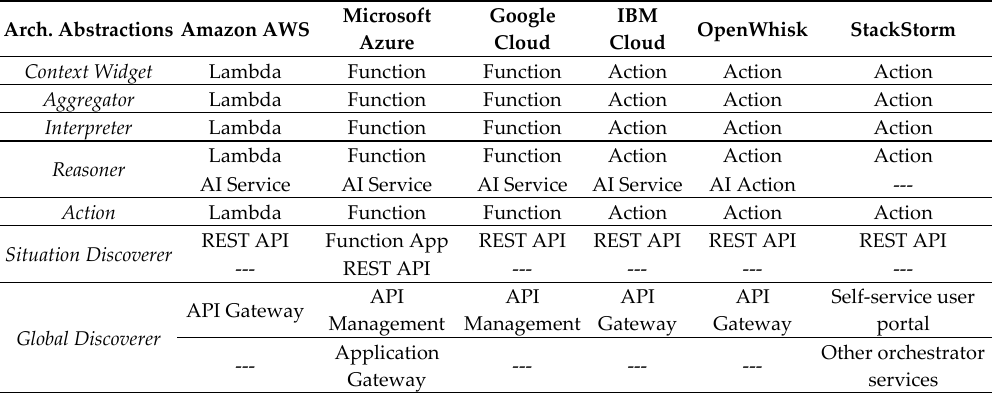
Table 1. Traceability from the architectural abstractions to cloud platform services or